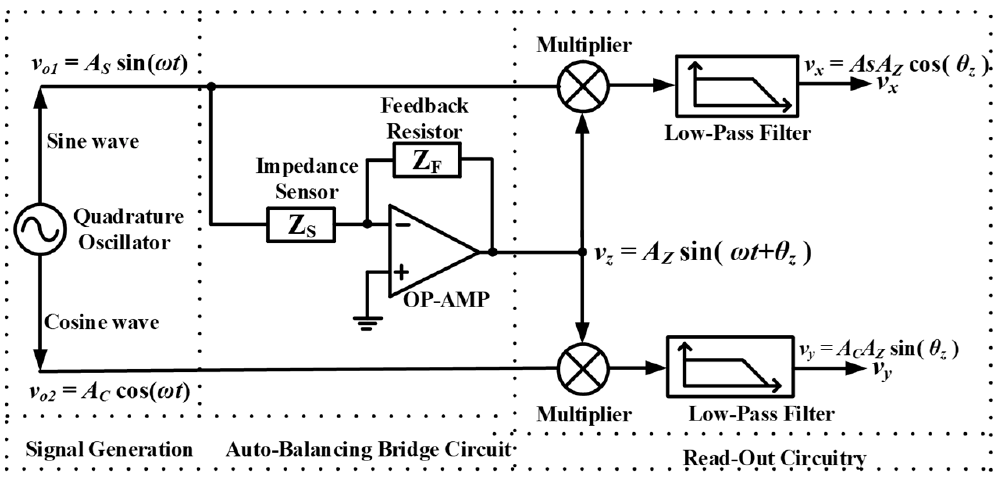
Figure 1. The conceptual scheme of a dual PSD system.